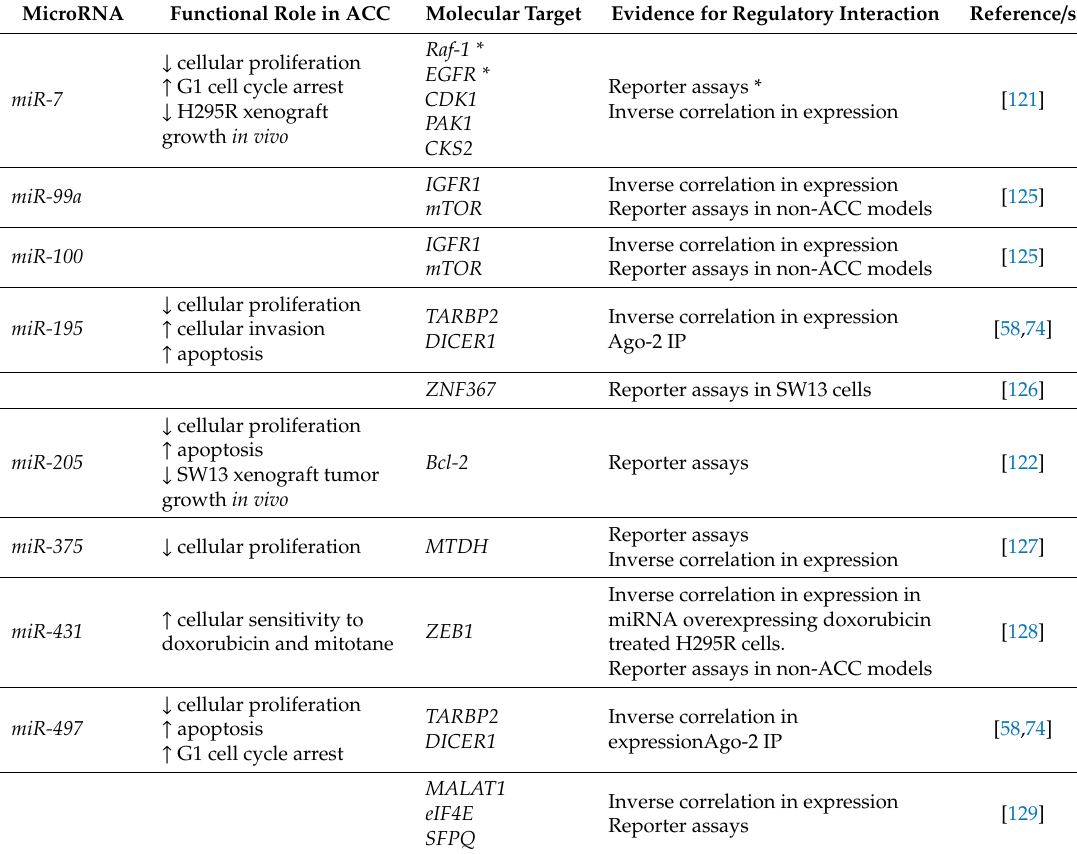
Table 4. Underexpressed microRNAs and their regulated targets in